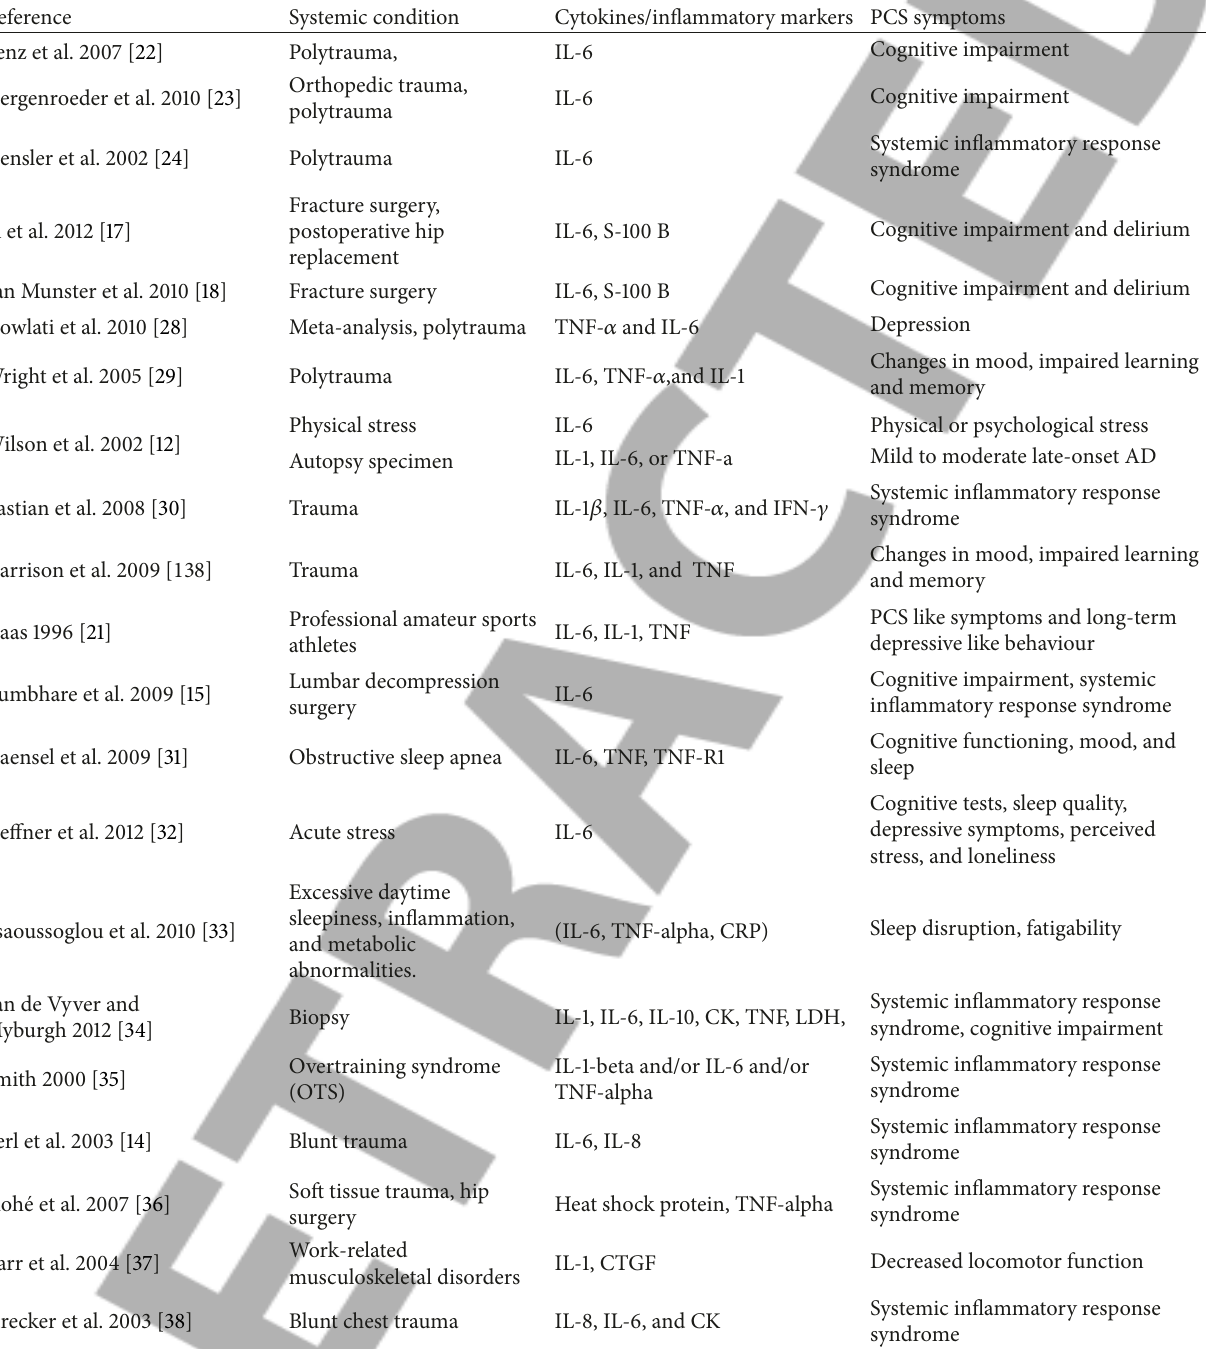
Table 1: The literature overview that studied cytokines release in condition other than TBI, infections, cardiac conditions, HIV, strokes, cerebrovascular conditions, cancers, immunotherapy, MS, or any condition in which the neurocognitive dysfunction is